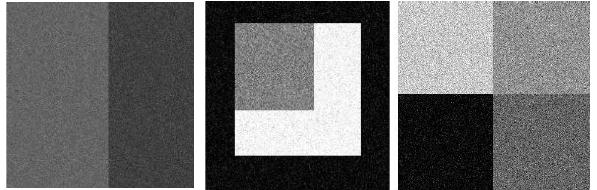
Figure 8. The synthetic test